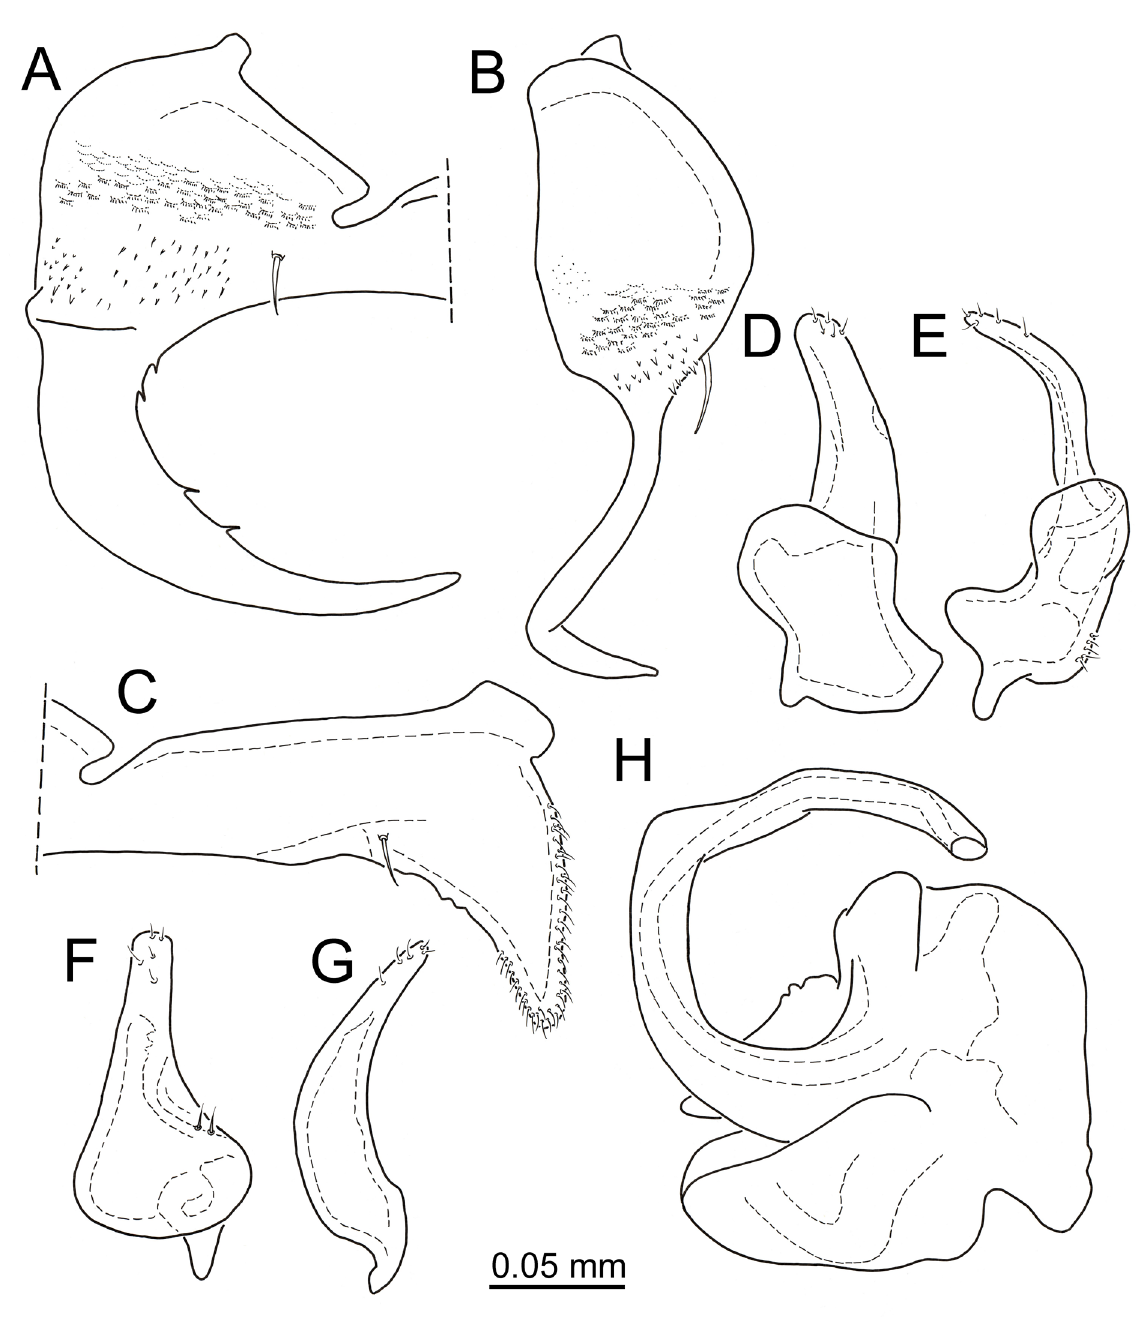
Fig. 10. Kokeshia drepanoides sp. nov., segment VIII and genitalia, paratype, ♂ (SYSBM). A‒B . Left hemitergite VIII. A . Dorsal view. B . Left lateral view. C . Right hemitergite VIII, dorsal view. D‒E . Left paramere, two different aspects. F‒G . Right paramere, two different aspects. H .